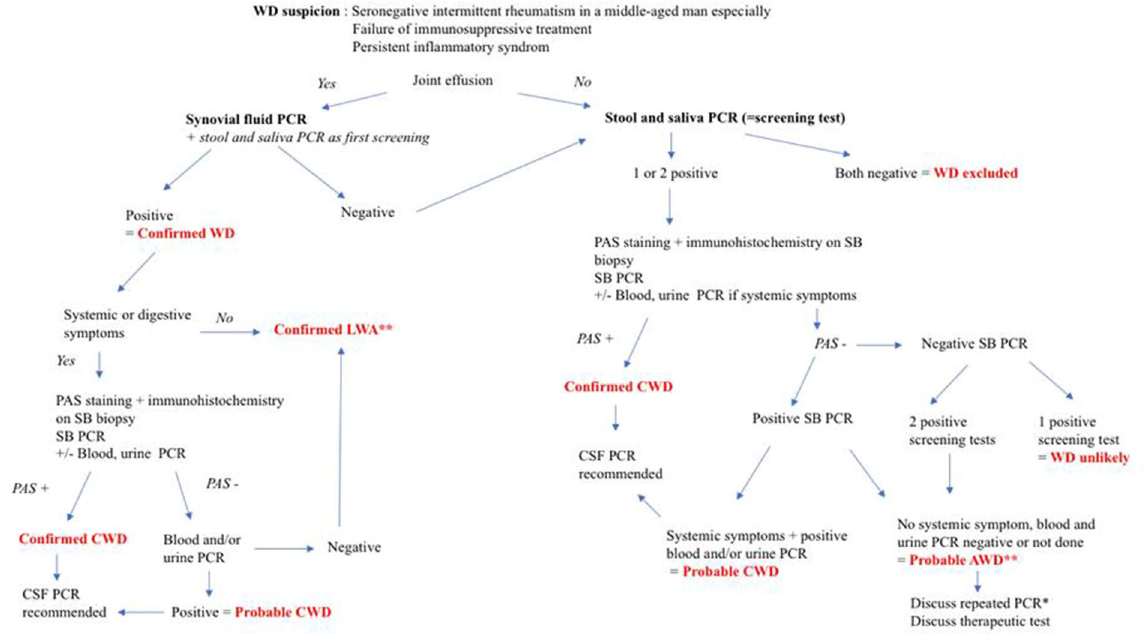
Figure 2. Proposed algorithm for Whipple disease in patients in whom rheumatism is suspected. CSF cerebro- spinal fluid, CWD classic Whipple disease, PAS periodic acid-Schiff, SB small bowel, WD Whipple disease. Cases of spondylodiscitis not considered in this algorithm. **Discuss CSF PCR in case of neurologic symptoms. *In case of chronic arthritis with negative synovial fluid PCR, discuss synovial biopsy. NB Data on cutaneous biopsy PCR were to scarce in our cohort integrate it on the